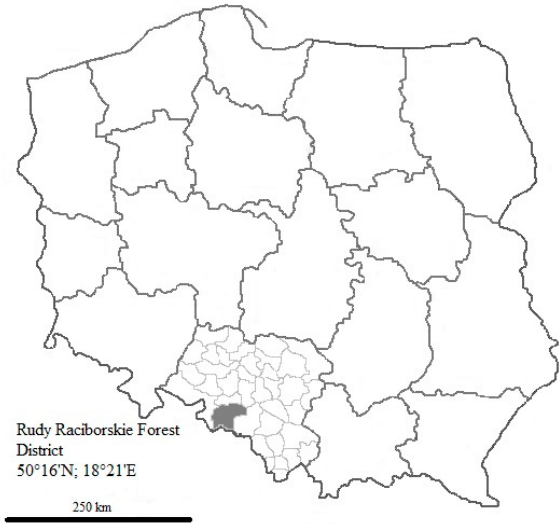
Figure 1. Map of Poland with the research area.